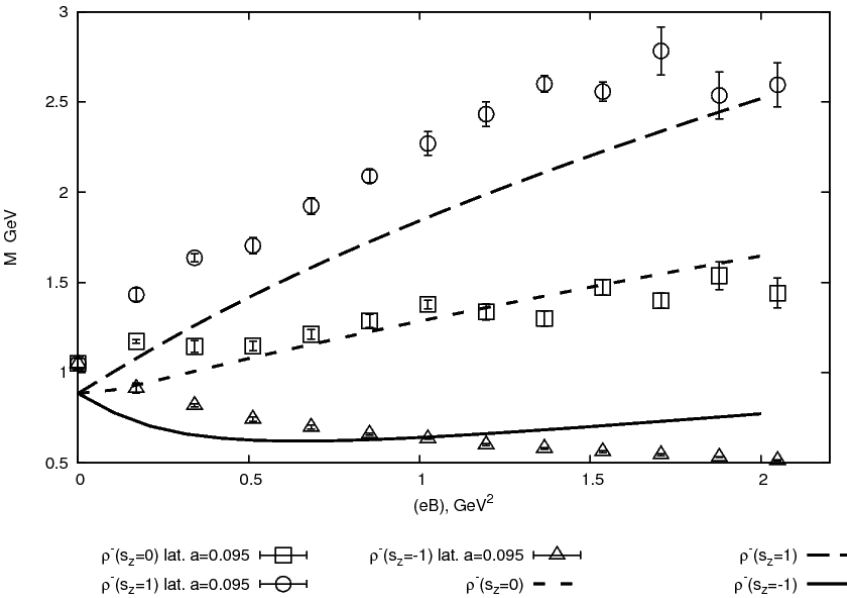
Figure 7 . The (cid:26) (cid:0) meson mass evolution in MF from our analytic (PIH) and lattice data with a = 0 : 095 ; fm